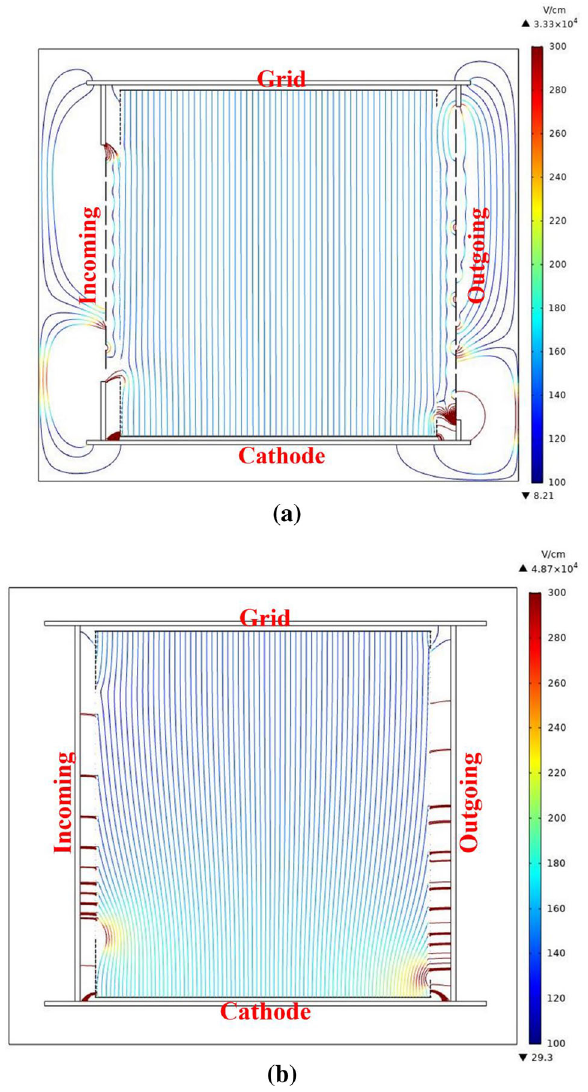
Fig. 9 Field cage electric field distribution of DSA structure sealed window ( a ) and SSA structure sealed window ( b ). The Cross section is the side view of detector which is shown in the Fig.